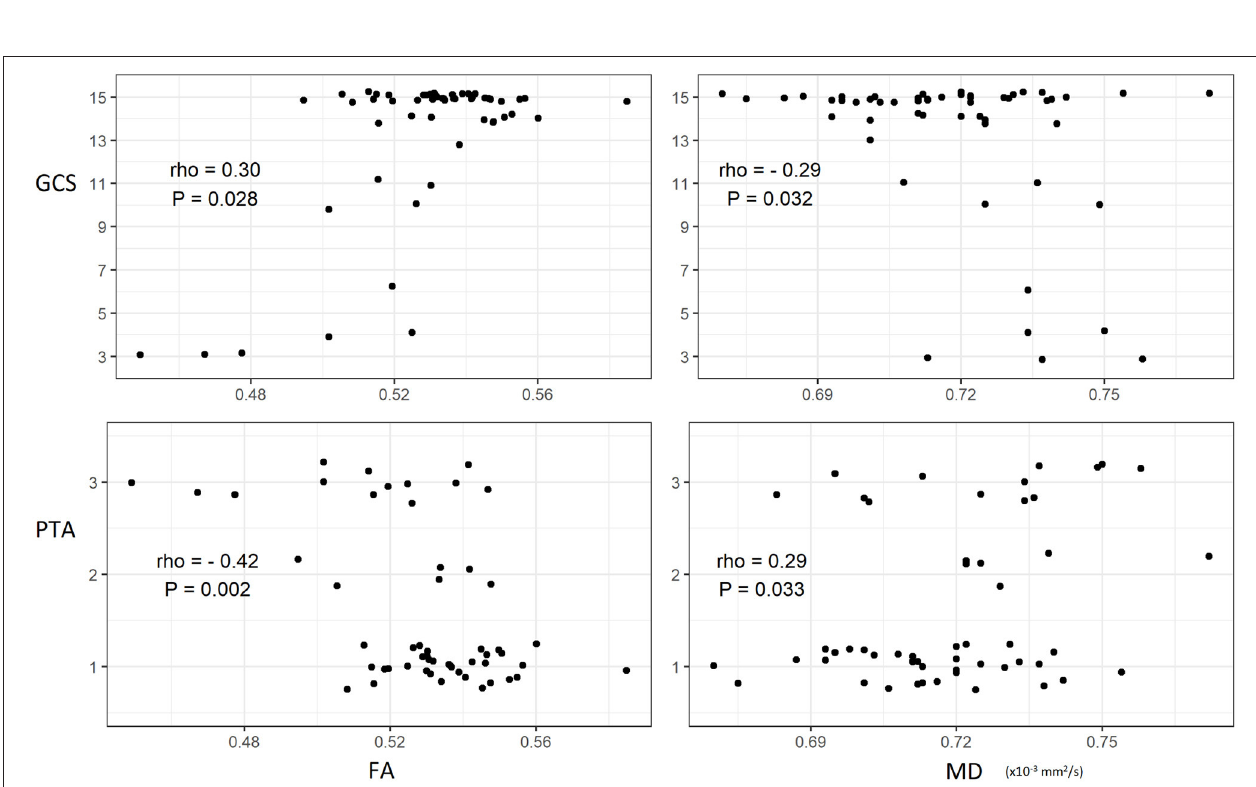
FIGURE 6 | Scatterplots of clinical severity of traumatic brain injury and white matter microstructural properties including best fit lines with corresponding Spearman’s correlation coefficients and P -values. GCS, Glasgow Coma Scale; PTA, post-traumatic amnesia; FA, fractional anisotropy; MD, mean diffusivity.